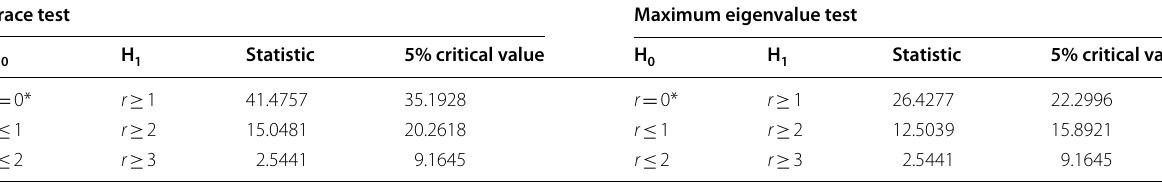
Table 7 Cointegration test results 1982 to 2021